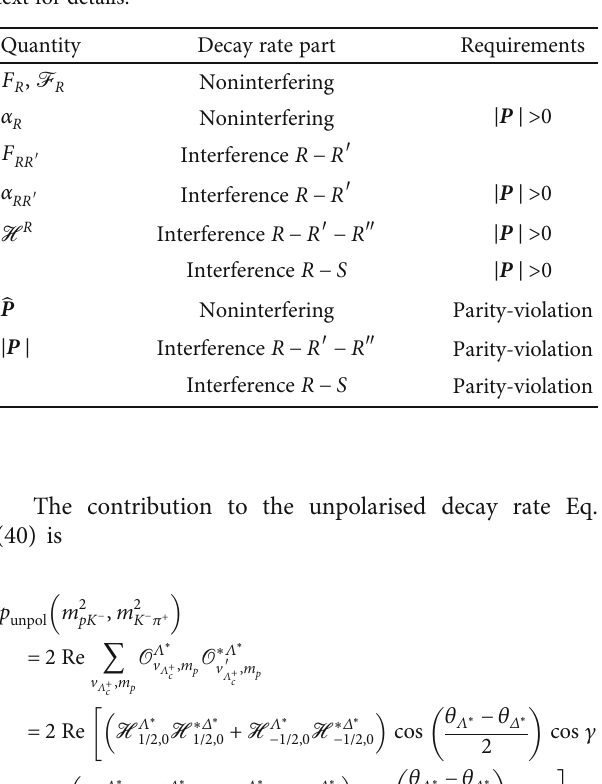
→ pK − π + decay rate study. It is Table 1: Summary of the Λ + c reported which part of the decay rate is necessary to get information on the model parameters under which conditions. See text for